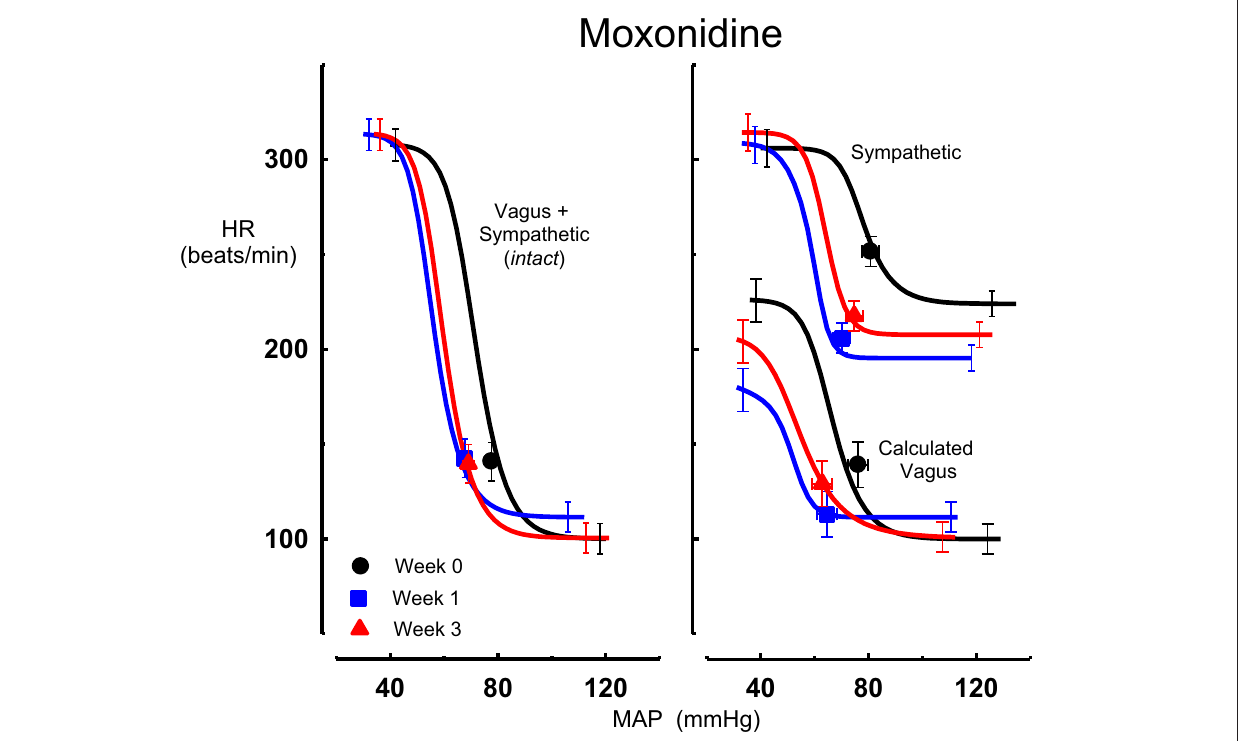
FIGURE 1 | Average sigmoid curves indicating the relationship between mean arterial pressure (MAP, mmHg) and heart rate (HR, beats/min) for the intact baroreflex curves (left panel) and the sympathetic and calculated vagal baroreflex curves (right panel) in six conscious rabbits before (weeks 0, black line, black circles on all panels) and at weeks 1 (blue line, blue square on all panels) and 3 (red line, red triangle on all panels) of moxonidine treatment. Symbols on curves represent resting values. Error bars are average SEM indicating variation between animals calculated from the